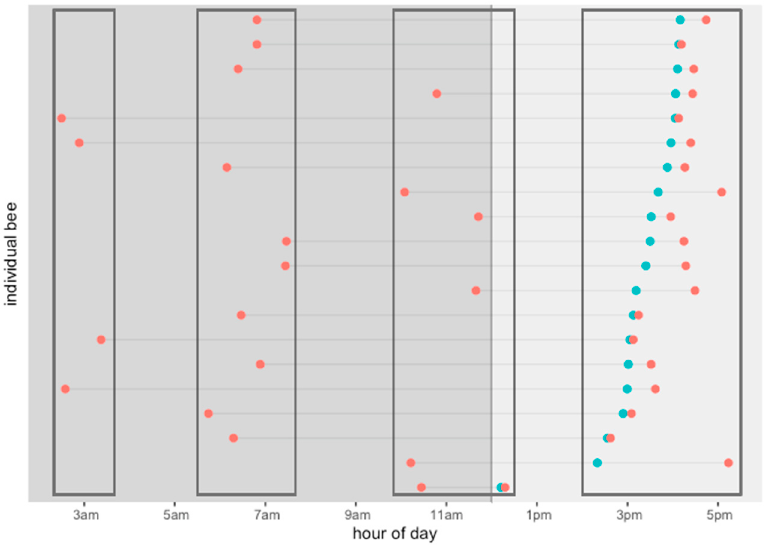
Figure 7. Activity pattern of twenty (20) RFID tagged drones that showed unusual activity times in one day, with flights lasting more than 60 min. They were divided into groups according to their departure time during the day. Departure (red) and arrival (light blue). Several drones remained inside the hive for up to four days, and some others re- mained for up to two or three days. Some drones remained outside the hive for up to three days. The number of drones outside the hive for 24 h was notably larger than the